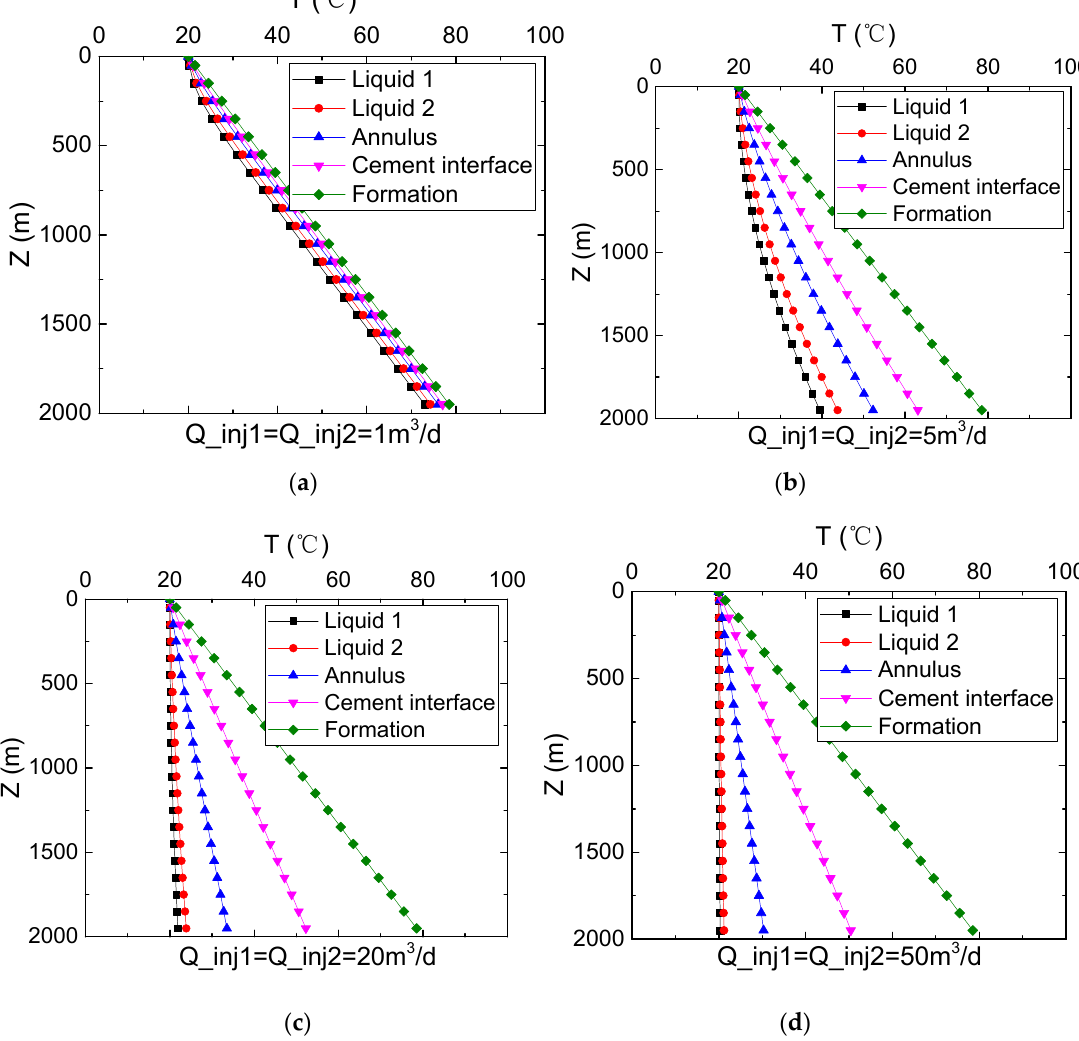
Figure 6. Temperaturedistributionindownholefordifferentlayers, asinjectingratesincreasing, thedynamic balance state becomes weak. The injecting rates are: ( a ) 1 m 3 / d, ( b ) 5 m 3 / d, ( c ) 20 m 3 / d, ( d ) 50 m 3 /